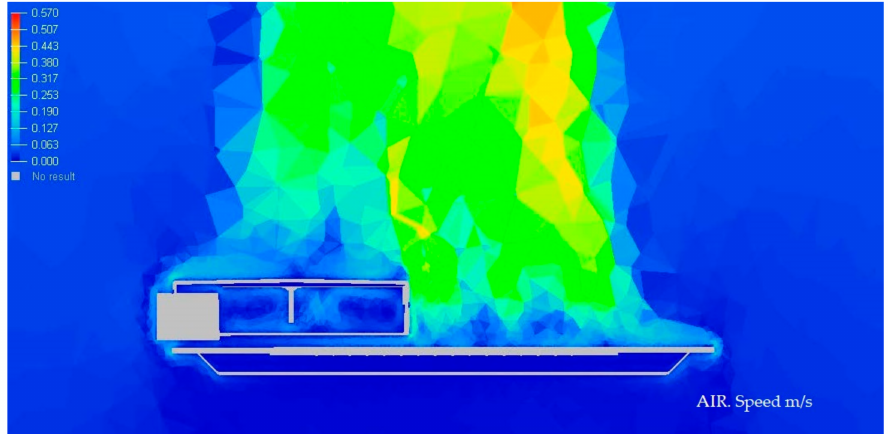
Figure 11. Speed section media of the luminaire at 40 ◦ C. Source: HyperView